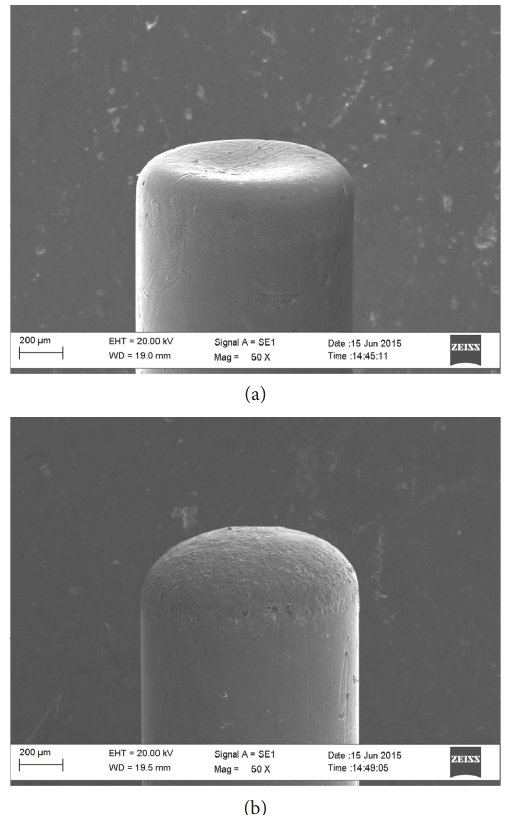
Figure 7: Changes of electrode shape with different polarity (no. 3 of Table 1). (a) Positive polarity machining. (b) Negative polarity